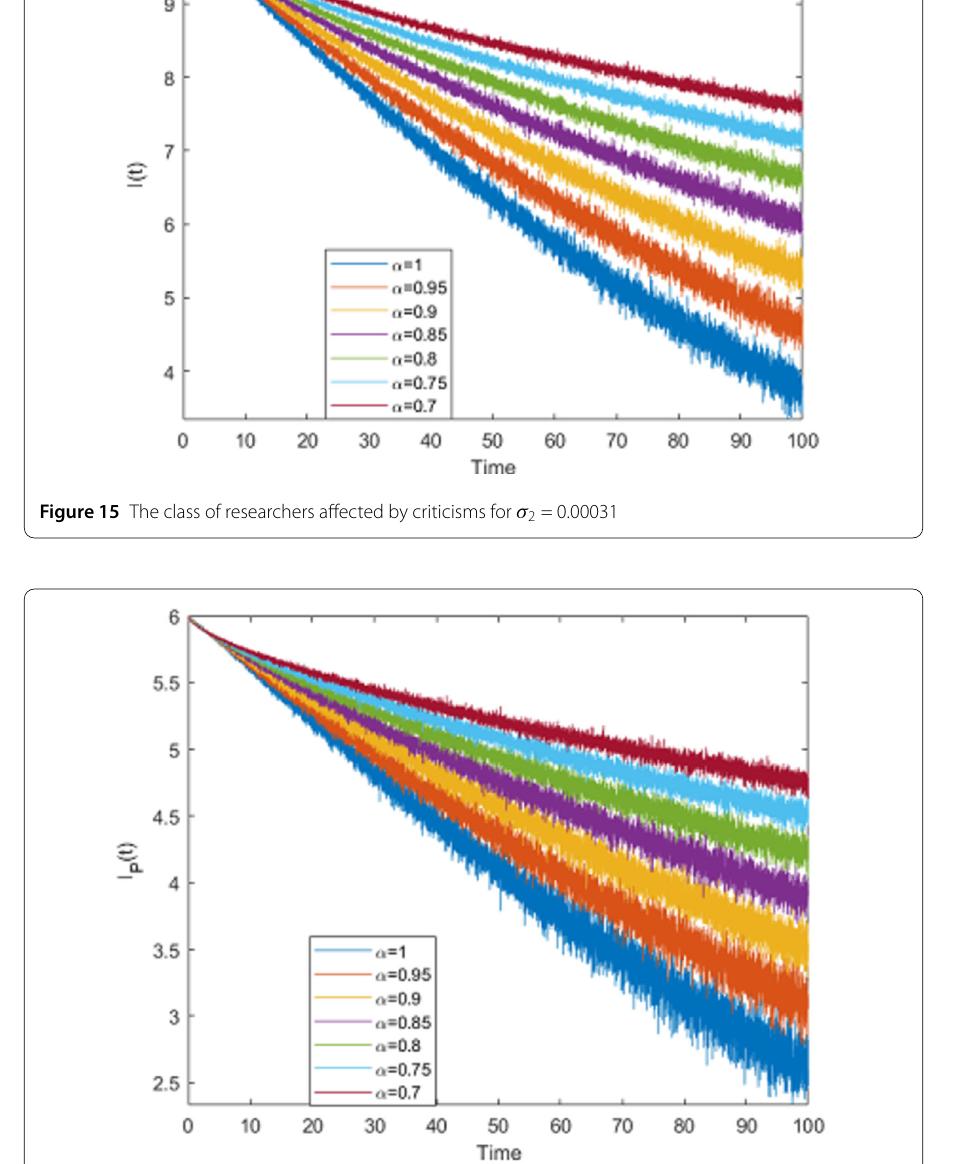
ferential and integral operators opened new doors both in theory and application of frac- tional calculus to solve real life problems. However, for some reasons, some researchers expected differential operators with nonsingular kernels to satisfy the properties of clas- sical derivative just as fractional derivative with singular kernel, which is absolutely im- possible because these operators are not used for the same purposes. For this reason, a new mathematical model depicting the survival of fractional calculus field was developed. New analysis that could be more informative, for example, toward the spread of any